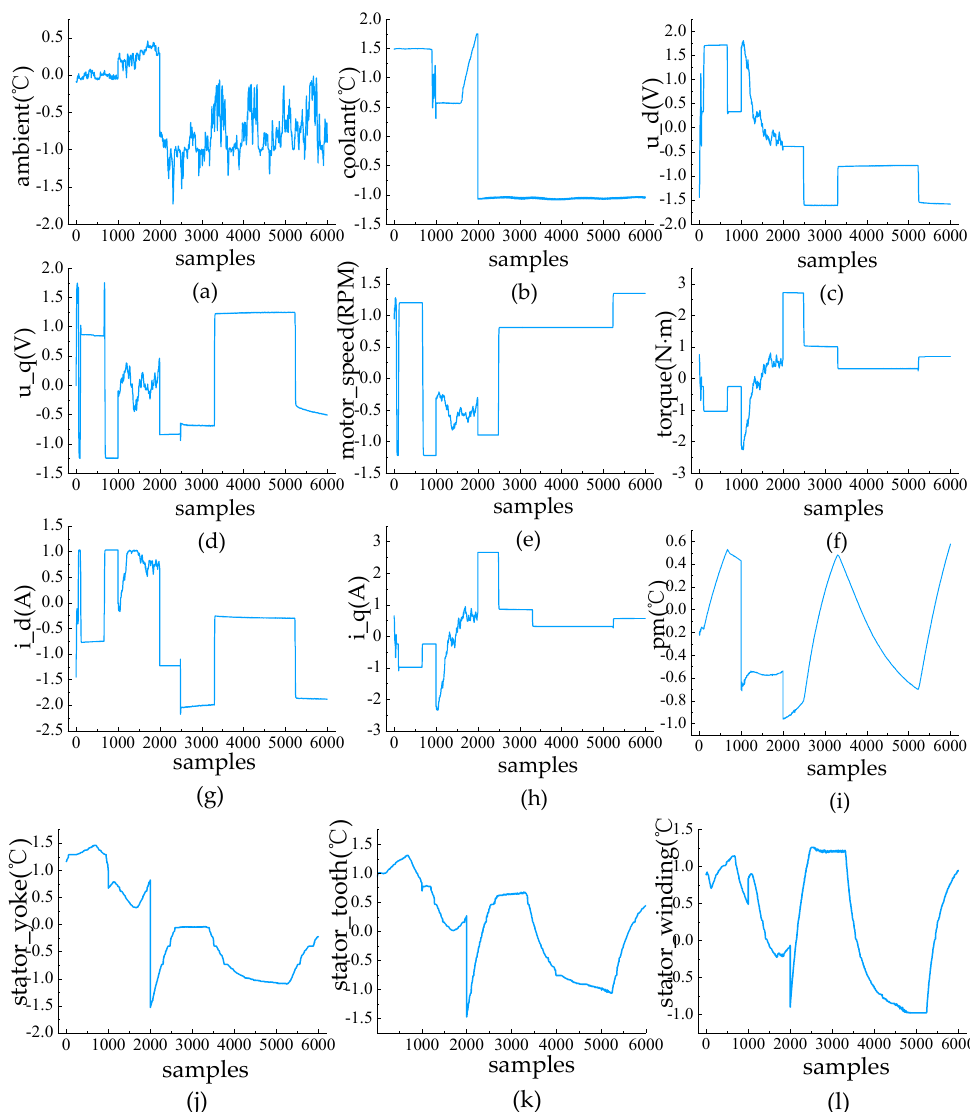
Figure 5. Dataset of the PMSM. ( a ) ambient temperature; ( b ) coolant temperature; ( c ) u_d; ( d ) u_q; ( e ) motor_speed; ( f ) torque; ( g ) i_d; ( h ) i_q; ( i ) pm; ( j ) stator_yoke; ( k ) stator_tooth; ( l ) stator_winding.